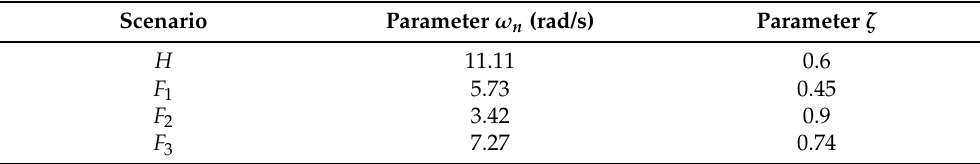
Table 2. Parameters for hydraulic pitch system under common faulty scenarios [26].